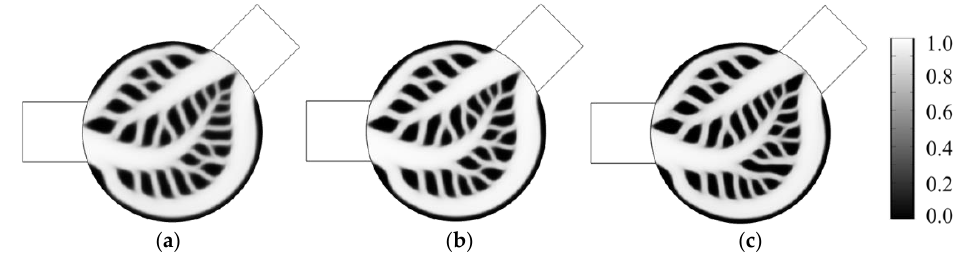
Figure 9. Optimal topology for mesh independence test. ( a ) Coarse mesh, ( b ) Medium mesh, and ( c ) Fine mesh. Table 2. Mesh details for the mesh independence test. Mesh